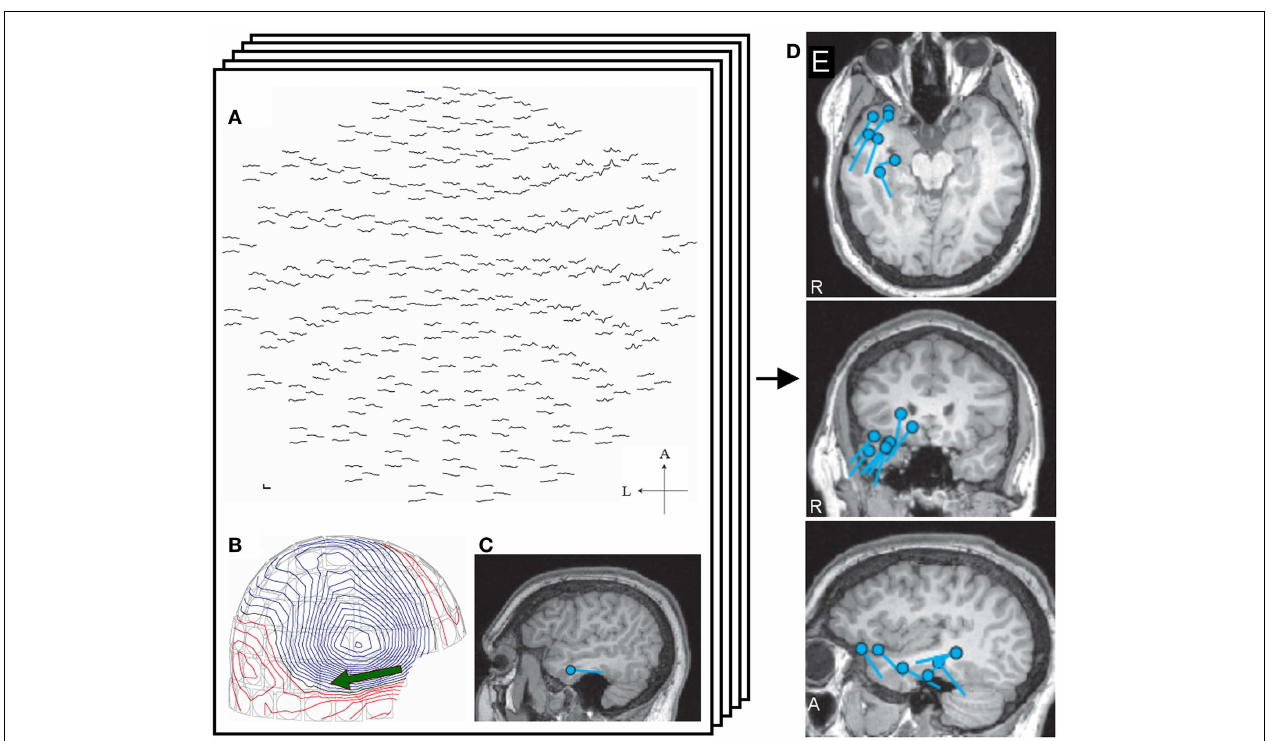
The equivalent current dipole (ECD) is projected on the patient’s MRI and is located in the right temporal lobe (C) . ECDs obtained from different spikes are collected and mapped on the MRI, providing ECD distribution maps (D)